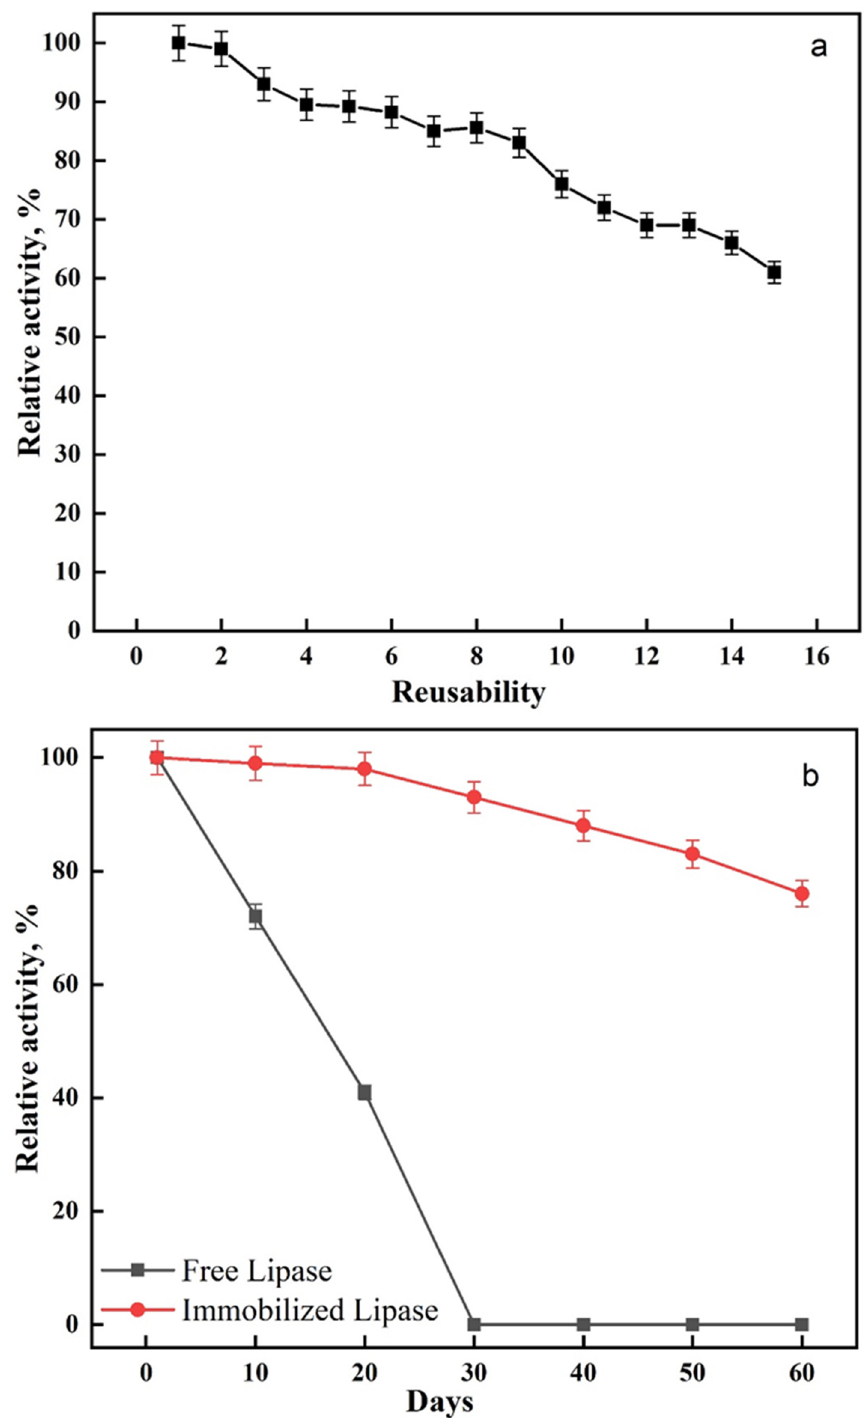
Figure 4. ( a ) Reusability and ( b ) storage stability of the lipase